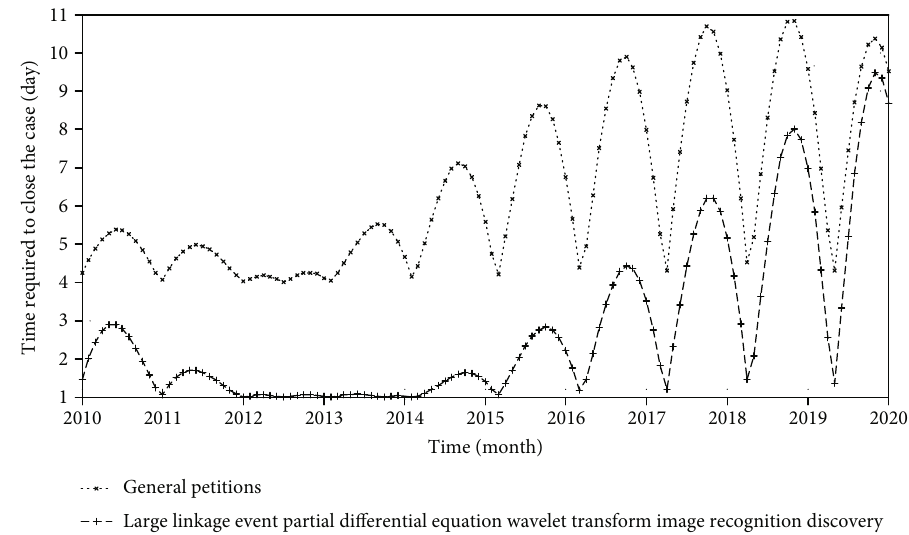
Figure 8: Image recognition based on partial di ff erential equations and wavelet transform, and the time required to close the case of letters and